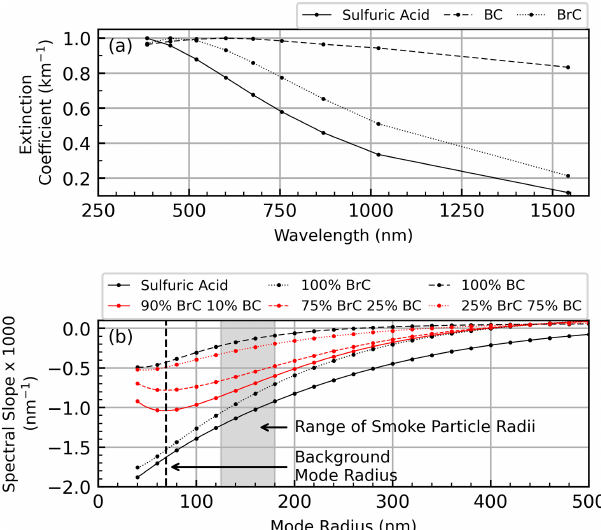
Figure 1. Spectra of extinction coefficients (normalized to 1) as a function of wavelength using a fixed mode radius of 200nm and dis- tribution width of 1.5 (a) ; spectral slope as a function of mode radius using a constant distribution width of 1.5 (panel b ; see Sect. 4 for details on slope calculation) from the Mie theory simulation. Nor- malization in (a) was carried out by dividing each curve by its maxi- mum value. The vertical dashed line in (b) indicates the background mode radius at 20km, per Deshler et al. (2003). The gray-shaded re- gion in (b) indicates a range of smoke particle radii (Moore et al.,